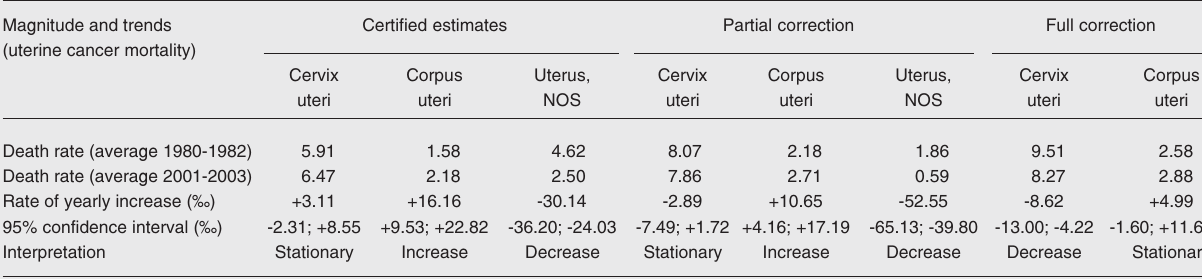
Figure 3. Corpus uteri cancer mortality rates in São Paulo, Brazil, 1980-2003, corrected or not for NOS (not otherwise specified). Data are reported as fre- quency per 100,000 women with NOS on death cer- tificate (certified), partially corrected to eliminate NOS (partial) of fully corrected.